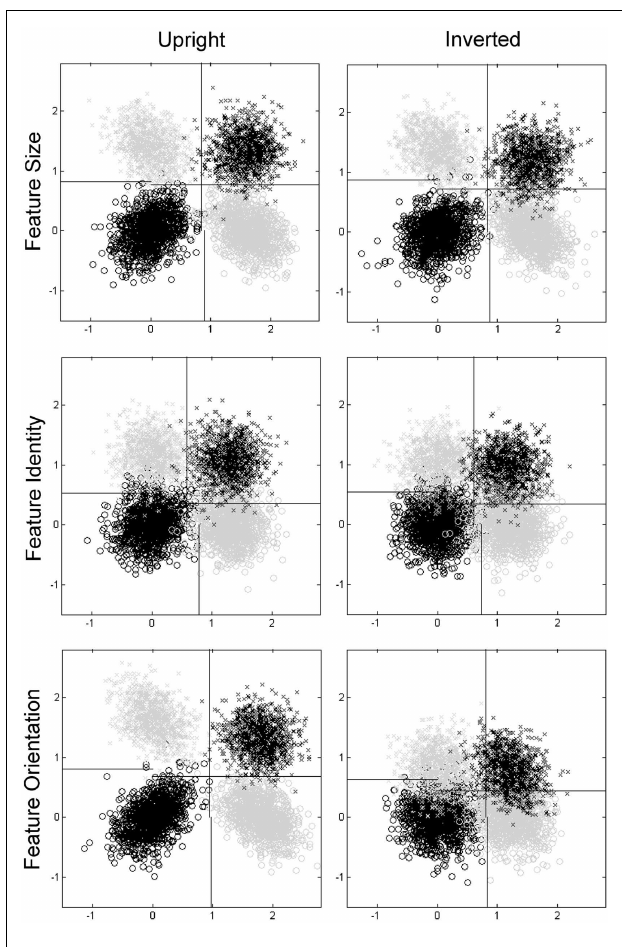
FIGURE 5 | Plots of distributions and decision criteria from probit analyses. Same (normal) top, same (normal) bottom = black circles, different (odd) top, same (normal) bottom = gray circles, same (normal) top, different (odd) bottom = gray crosses, different (odd) top, different (odd) bottom = black crosses. Note distributions are plotted relative to an origin at the mean of the bivariate dimensions for the same-same (normal-normal) case. Plots paneled by task (Feature Size, Feature Identity, and Feature Orientation) and orientation condition (upright and inverted).